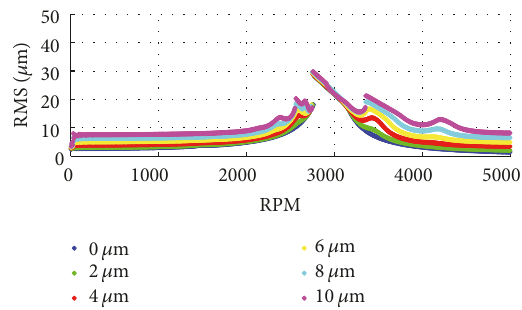
Figure 11: RMS of the different DTE curves obtained by using different average values of STE.